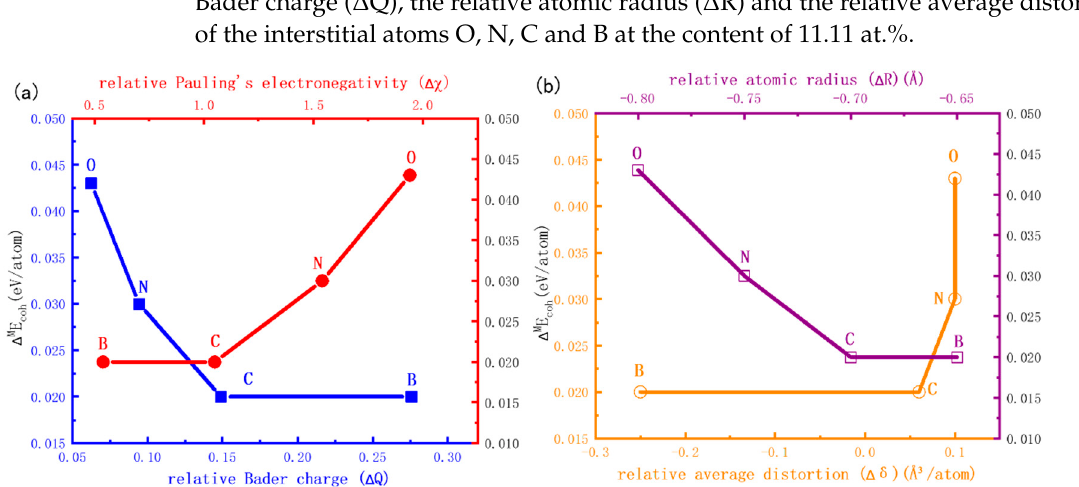
difference in Bader charge; (b) The atomic radius and the difference in average distortion of the